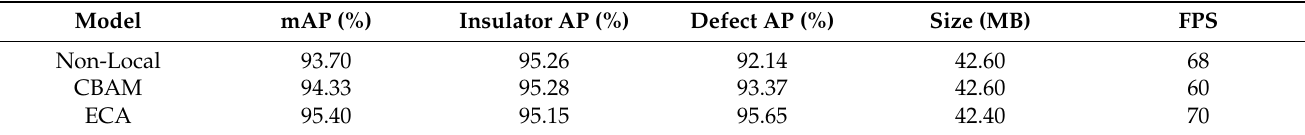
Table 2. Comparison of cross-sectional effects of attentional